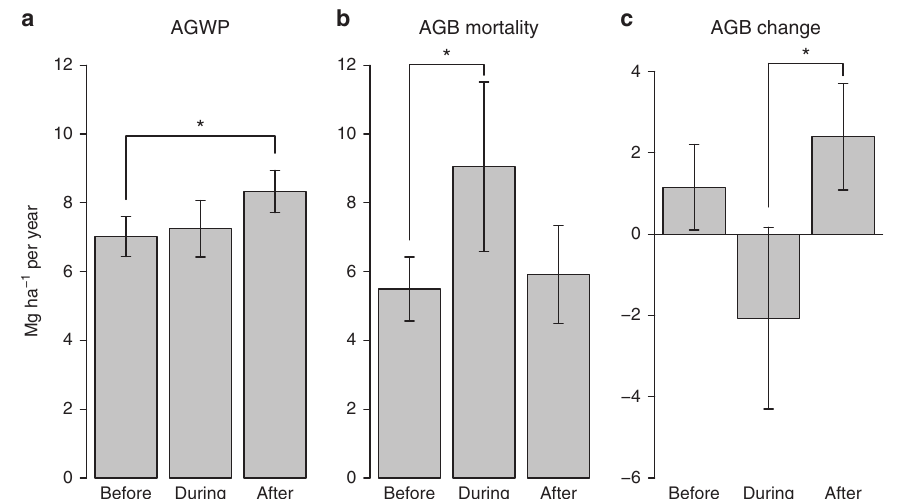
Fig. 6 Biomass dynamics in 19 forest interior plots in Borneo that were monitored over the 1997 – 1998 El Niño. Above-ground wood productivity (AGWP, a ), above-ground live biomass (AGB) mortality ( b ) and AGB change ( c ) were estimated for three mean time intervals: before drought 1978.6 – 1996.5, during drought 1996.5 – 2000.0 and after drought 2000.0 – 2011.1. Values shown are estimated from linear mixed effects (LME) models with 95% CIs (bars) for the 19 plots. Asterisks indicate signi fi cant difference based on non-overlapping CIs. Before – during – after trajectories for individual plots for each variable are presented in Supplementary Fig.